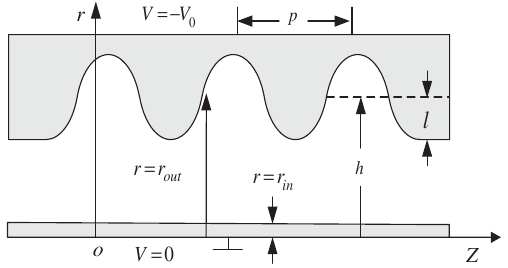
FIG. 2. Cylindrical coordinate system ð R; ’; z Þ adopted in the present